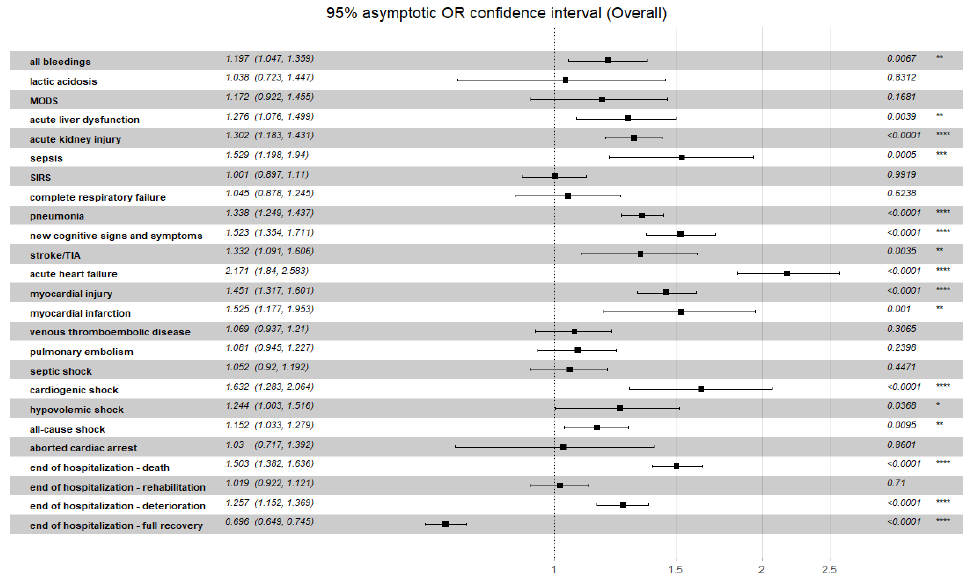
Figure 4. Overall odds ratio for the discriminatory performance of the C 2 HEST score for clinical non-fatal events in CAD cohort. p -value: Significance code. **** p < 0.0001, *** p < 0.001, ** p < 0.01, * p < 0.05.